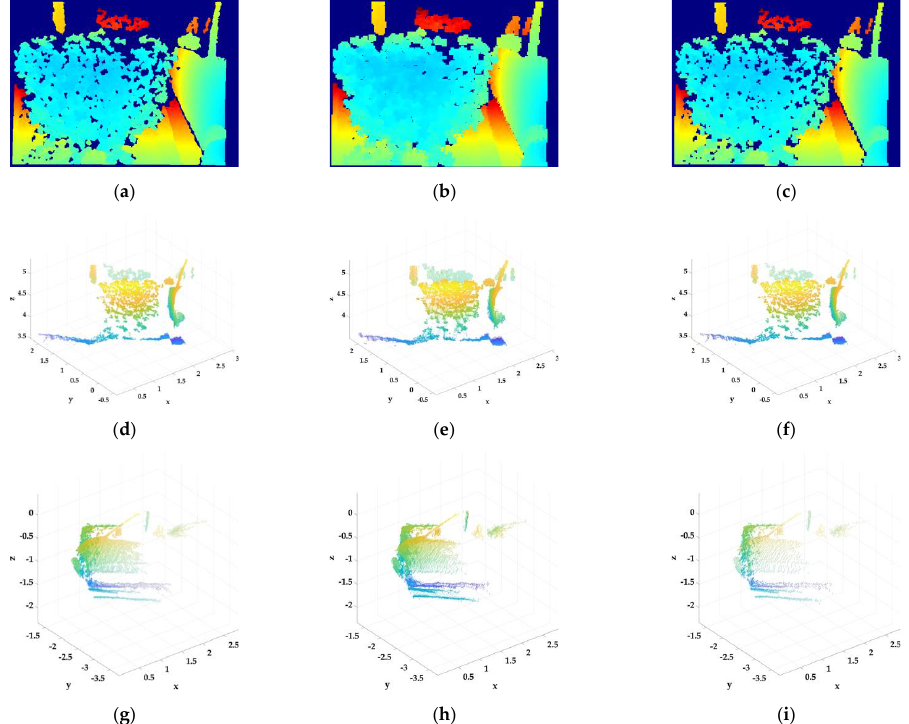
Figure 18. Validation of fractional−order differential Kriging interpolation super−resolution model (dataset no. 04797). ( a, d, g ) Original depth images; ( b, e, h ) Outputs of fractional−order differential Kriging interpolation super−resolution model ( 𝜈 = 0.6, PSNR = 33.819 dB); ( c, f, i ) Outputs of nearest- neighbour interpolation super−resolution model (PSNR = 21.051 dB).